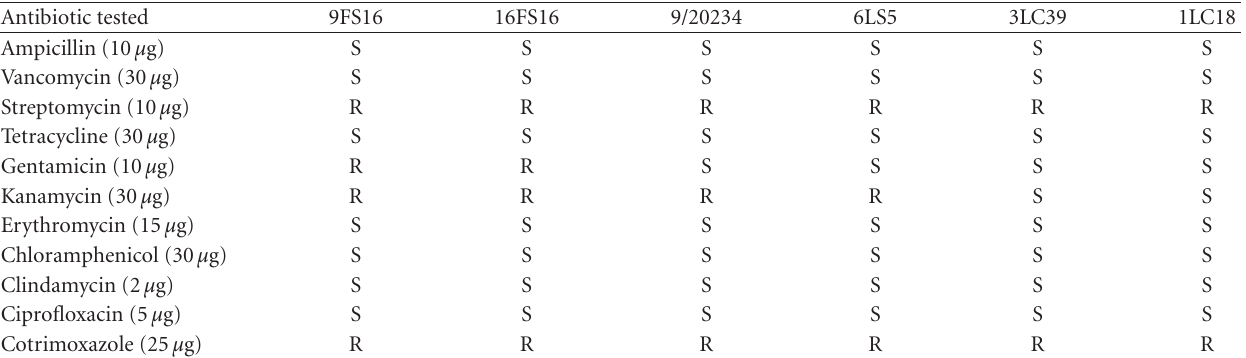
Table 3: Antibiotic resistance of the six bacteriocin-producing Lactococcus lactis subsp. lactis strains isolated from artisanal dairy products. Antibiotic